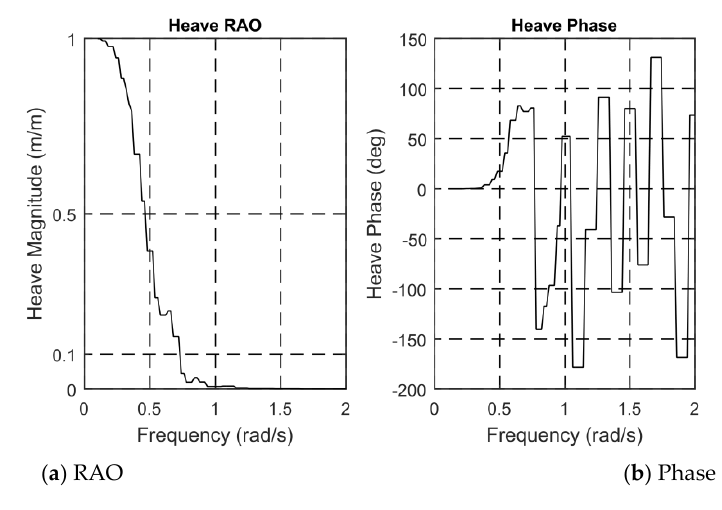
Figure 5. Heave transfer function of FPSO.